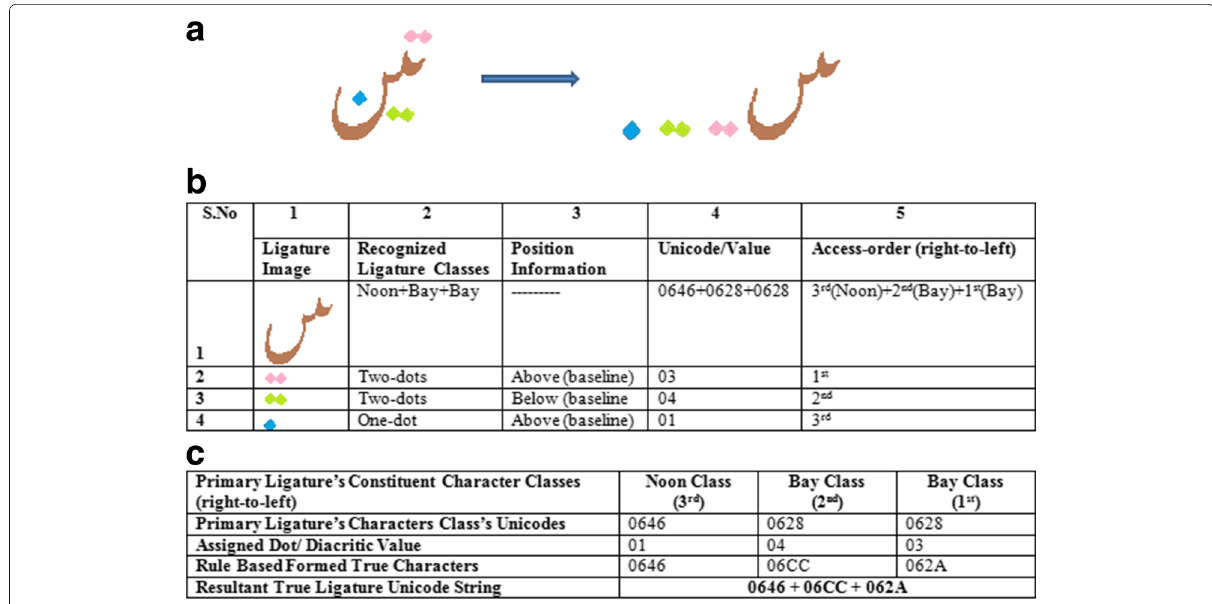
Fig. 16 a Splitting a complete ligature as primary and secondary components. b Recognized primary and secondary ligatures with the position and access-order information of secondary ligatures. c Assignment of recognized secondary ligatures to character classes of primary ligature to determine true